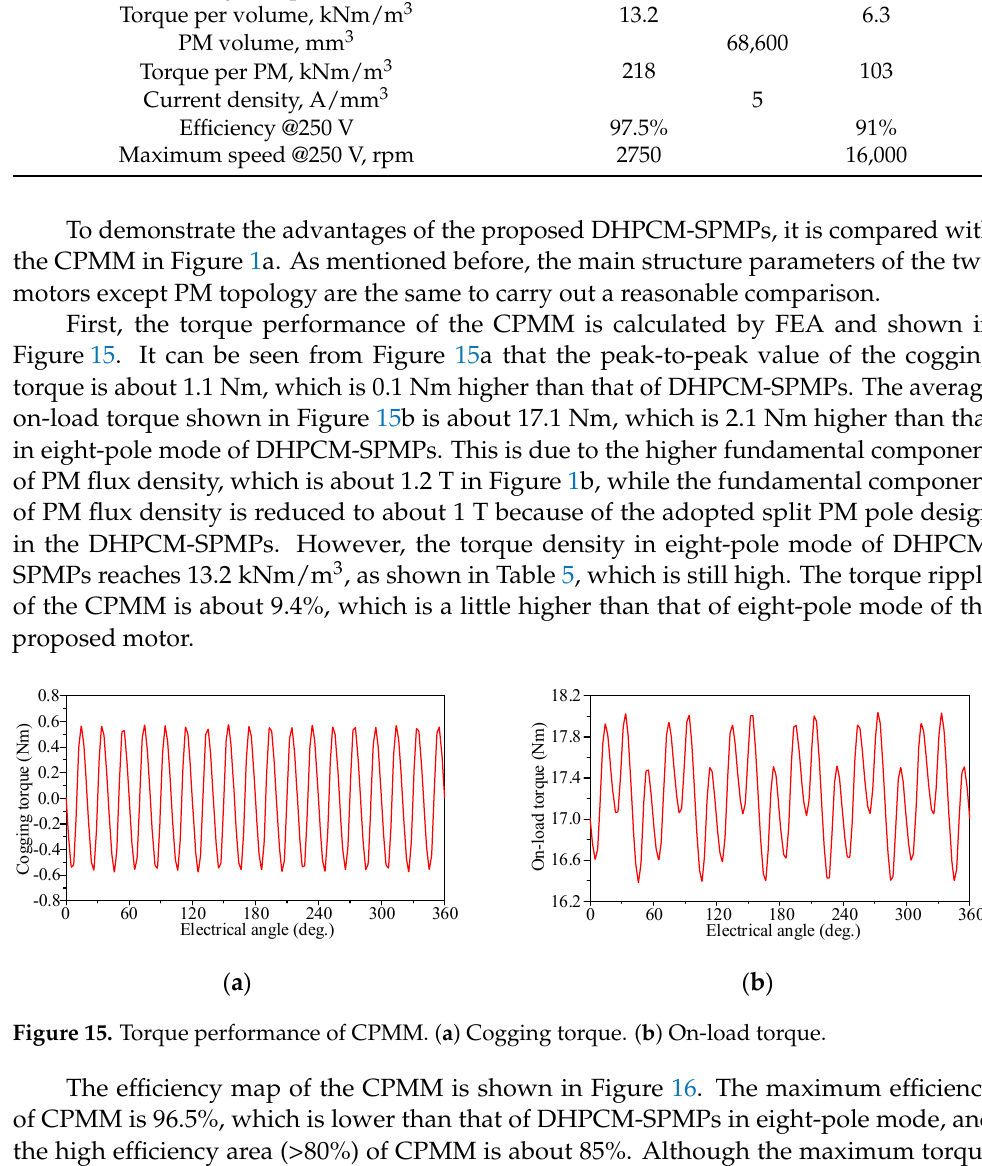
Figure 16. The efficiency map of CPMM.